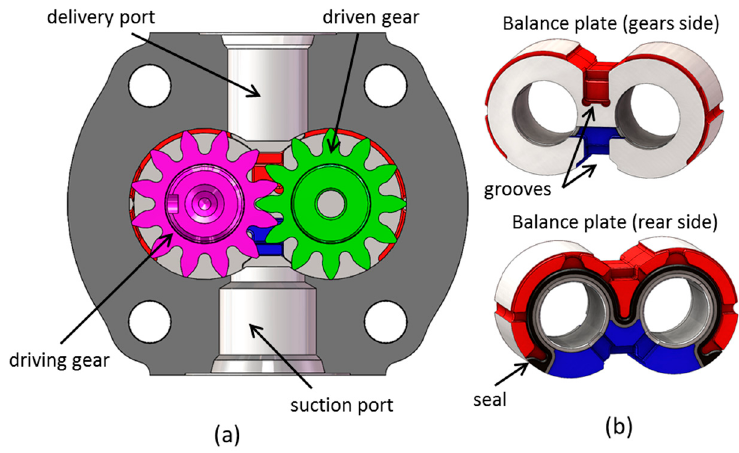
Figure 3. ( a ) Example of an external gear pump; ( b ) detail of the balance plates.